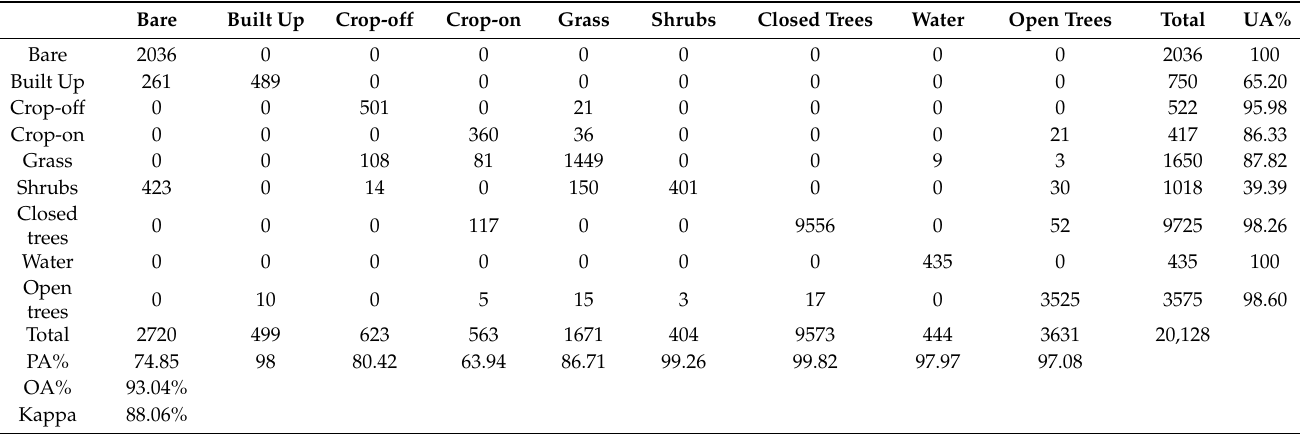
Table 1. Confusion classification matrix for the landscape classes in the Northern Kenya/Southern Ethiopia study region mapped using the Landsat 5 TM composite images for 1990, and using random forest as a classifier.